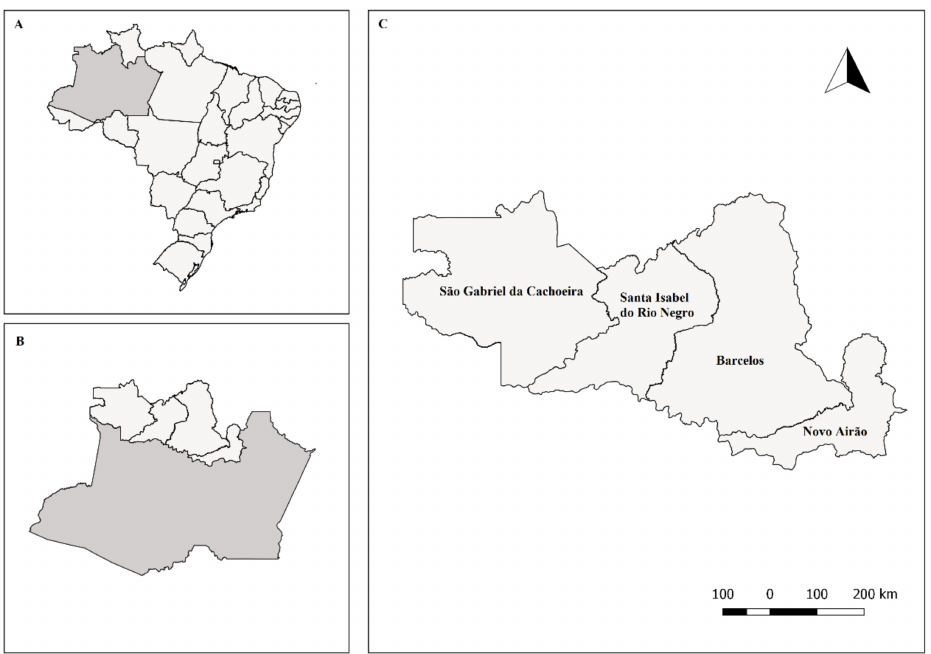
Figure 1. Location of the Amazonas state in Brazil ( A ) and location of the Rio Negro micro-region of the Brazilian Amazon ( B ), which is composed of four cities ( C